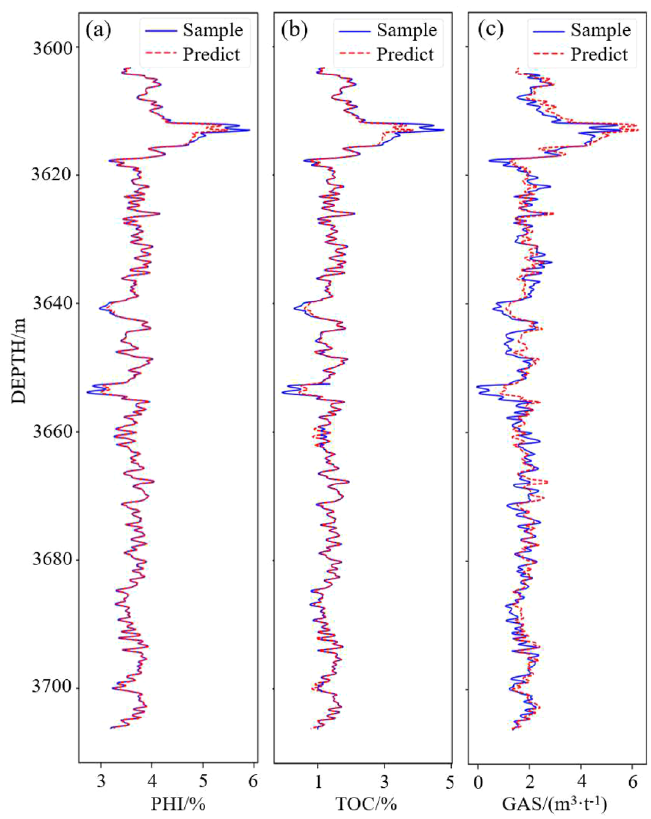
Figure 10. Comparison of predictions and samples of well WY11.